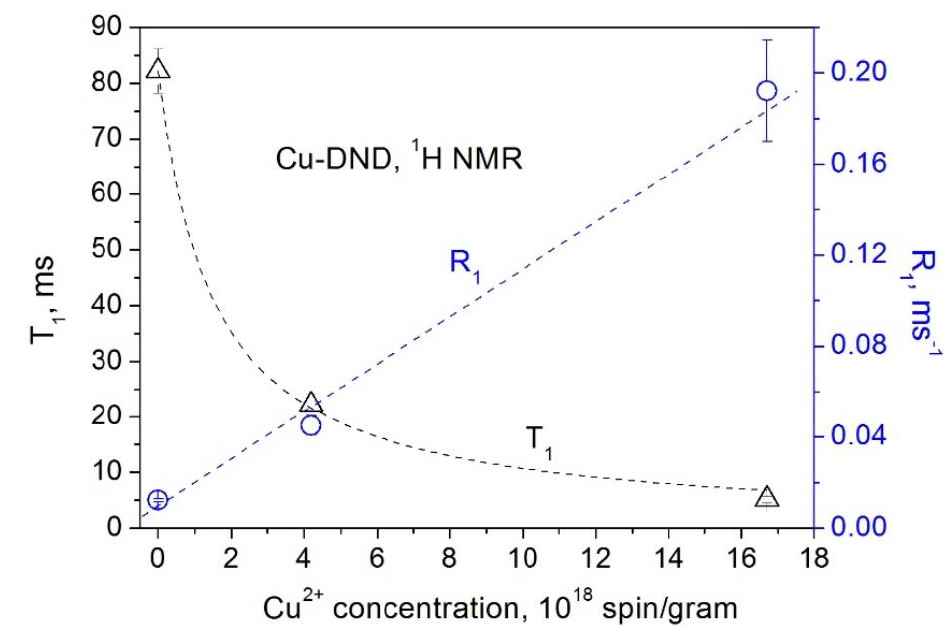
Figure 5. Dependence of the 1 H spin – lattice relaxation rate R 1 (circles) and the spin – lattice relaxa- tion time T 1 (triangles) in Cu-DND powders on the Cu 2+ ion concentration.